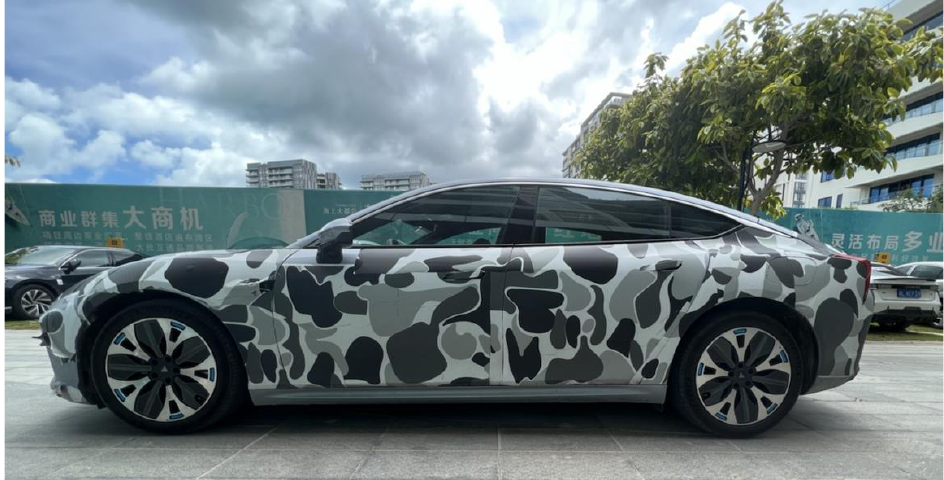
Figure 1. The target vehicle in this study.